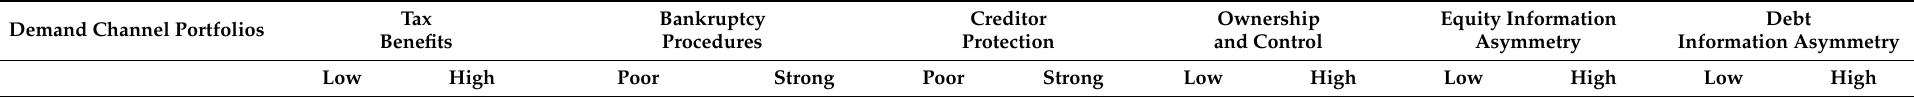
Panel A1. Deviation from Target 1